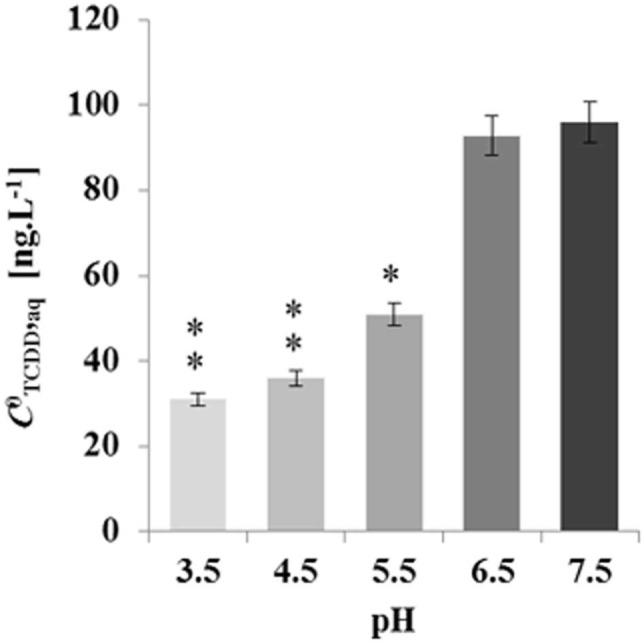
Decreasing the absorption activity of date palm LDs to TCDD as a function of the pH medium. TCDD [C0TCDD,aq (100 ng L-1)] was partitioned into LDs in suspension medium at various pH 3.5, 4.5, 5.5, 6.5, and 7.5. The sorption assay was carried out on a rotary shaker at 240 rpm for 60 min in the presence of 100 ng L-1 TCDD. Extraction and analysis of TCDD was performed as described in Section “Materials and Methods.” Three separated sorption experiments were done and the subsequent analysis of extracted TCDD by HR-GC/MS was done in triplicate. Data are mean values ± SD (n = 6). Statistical significance was evaluated by ANOVA analysis. Asterisks indicate significant differences between absorption at neutral and acidic media: ∗P < 0.05 (significant); ∗∗P < 0.01 (very significant).